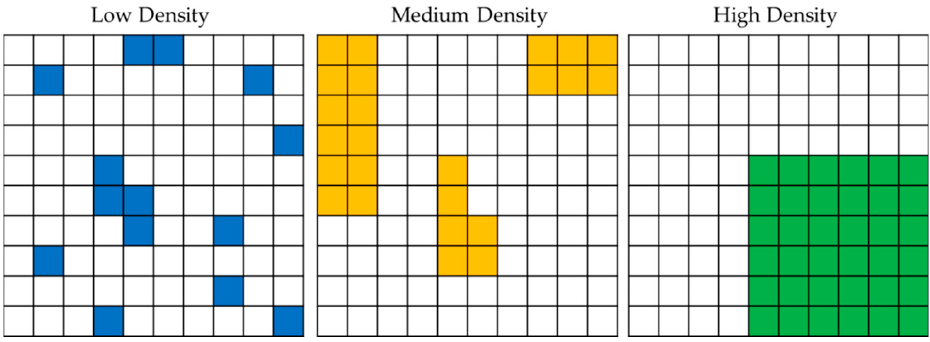
Figure 1. Main forms of urban structure.